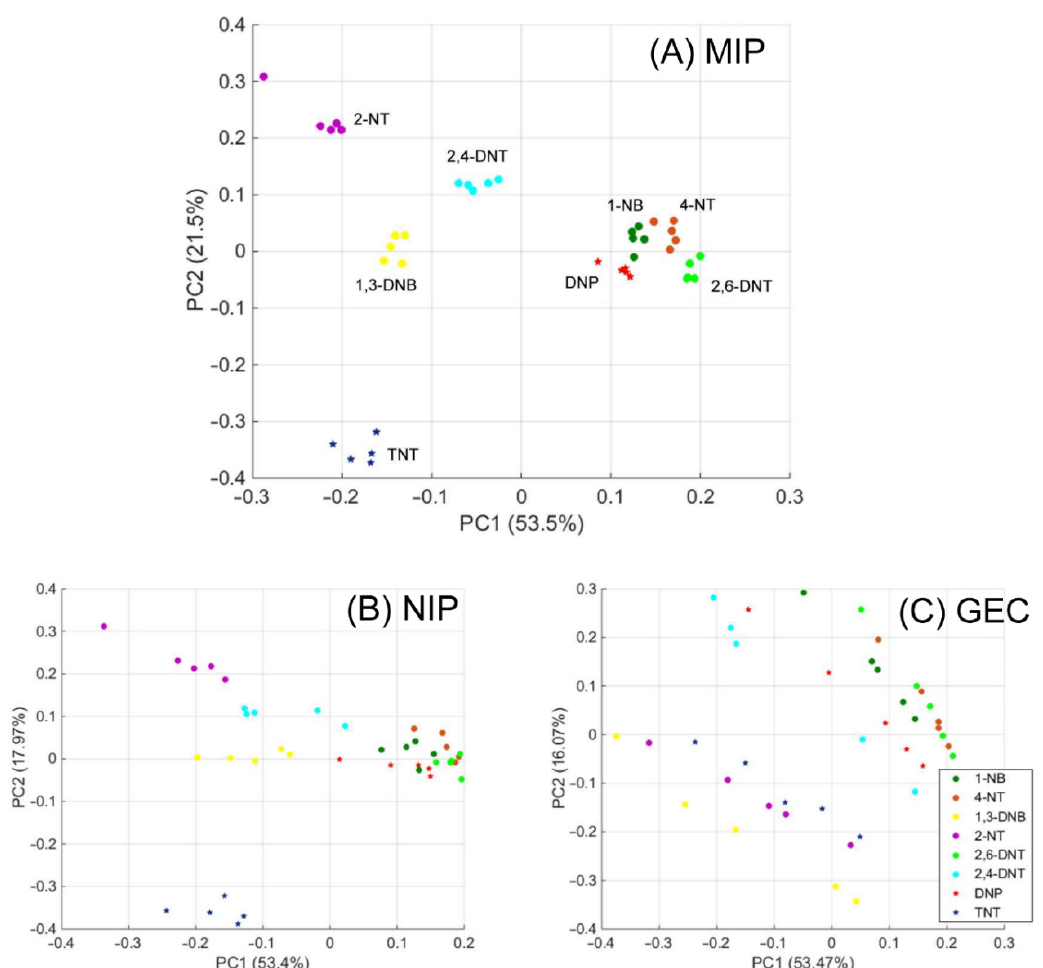
Figure 8. Score plots for each nitroaromatic compound performed with the voltammetric signals of ( A ) MIP, ( B ) NIP and ( C ) GEC sensors for five replicates of each nitroaromatic compound at 10 µmol L − 1 after principal component analysis.